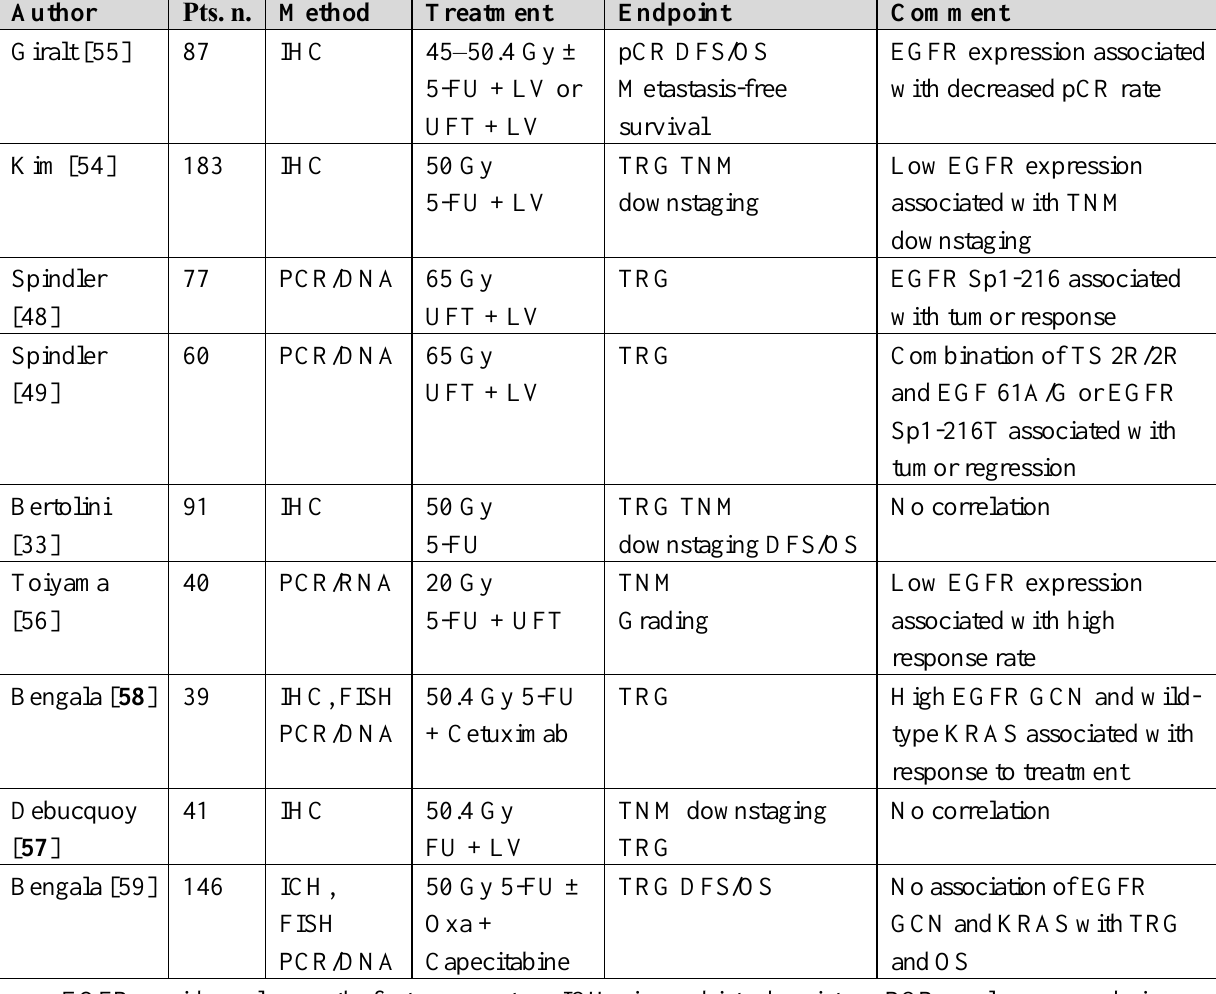
Table 3. EGFR expression and prediction of response to neoadjuvant radiochemotherapy in locally advanced rectal cancer